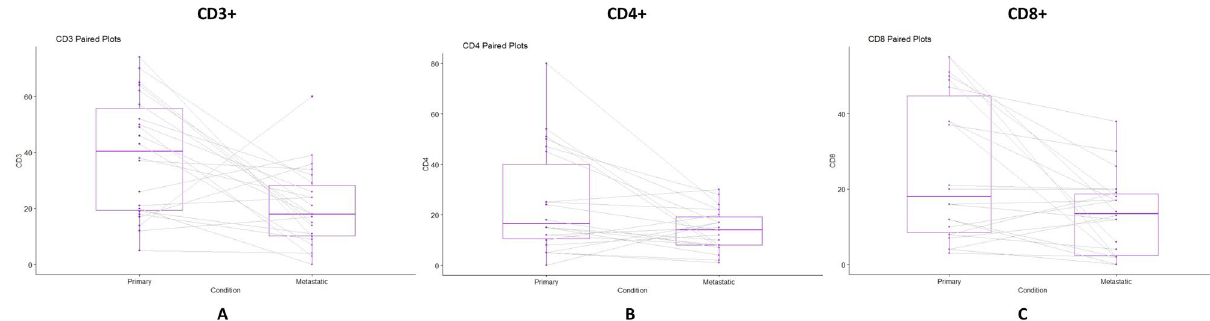
Figure 3. Paired box plots representing the immunomodulatory effects of pre-operative stereotactic radiotherapy on metastasis tumors compared to non-irradiated primary tumors on immunomodulatory cells, including CD3 + (T-cell receptor) ( A ), CD4 + (T helper cell) ( B ), and CD8 + (cytotoxic T lymphocytes) ( C